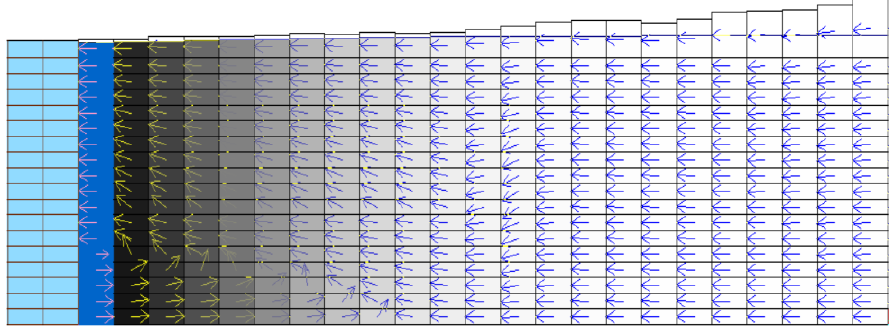
Figure A14. Inputs/Outputs balance on the coast from 2001 to 2100 under scenario RCP 8.5.